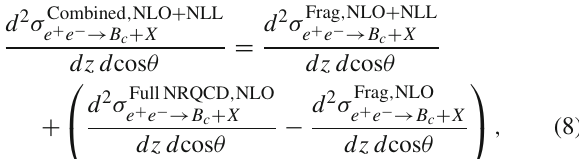
neglected terms can be recovered with the help of Eqs. (1, 5), and we then obtain the combined result of the fragmentation- function approach and the full NRQCD approach up to NLO level, i.e.